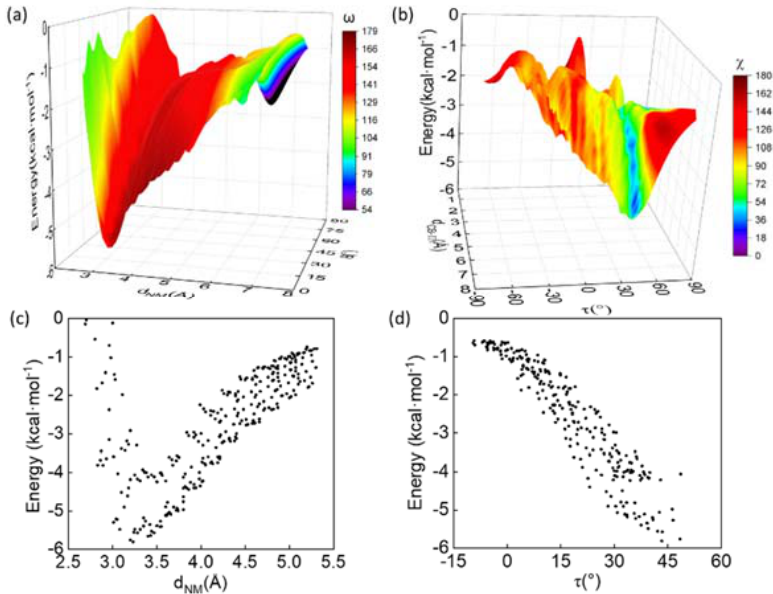
Figure 2. ( a ) Three-dimensional (3D) interaction energy ( ∆ E) surface is plotted against d NM and θ . The energy surface is color-coded with ω . The color scales are located on the right. ( b ) 3D ∆ E surface is plotted against d C γ - π and τ . The energy surface is color-coded with χ . The color scales are located on the right. ( c ) The data points with 0 < θ < 20 ◦ in the 3D-plot in ( a ) are projected on the ∆ E- d NM plane. ( d ) The data points with 40 ◦ < χ < 50 ◦ in the 3D-plot in ( b ) are projected on the ∆ E- τ plane.